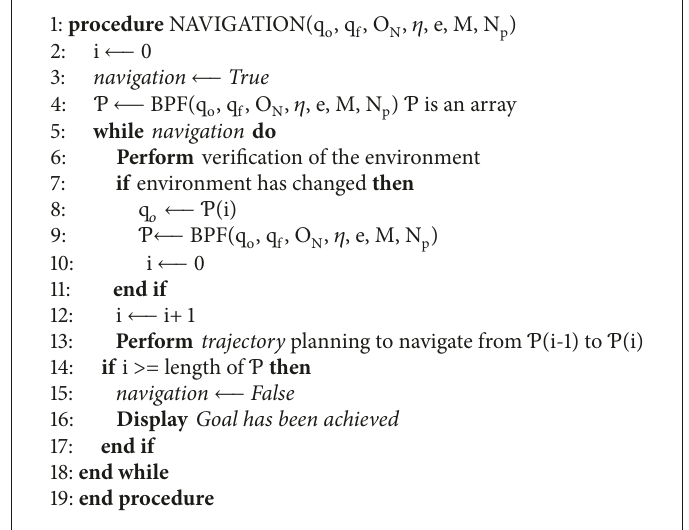
Algorithm 1: BPF